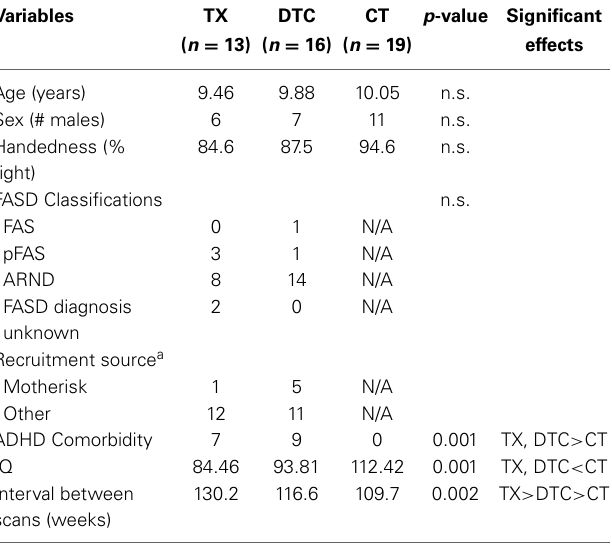
Table 1 | Demographic Characteristics of the FASD and Control